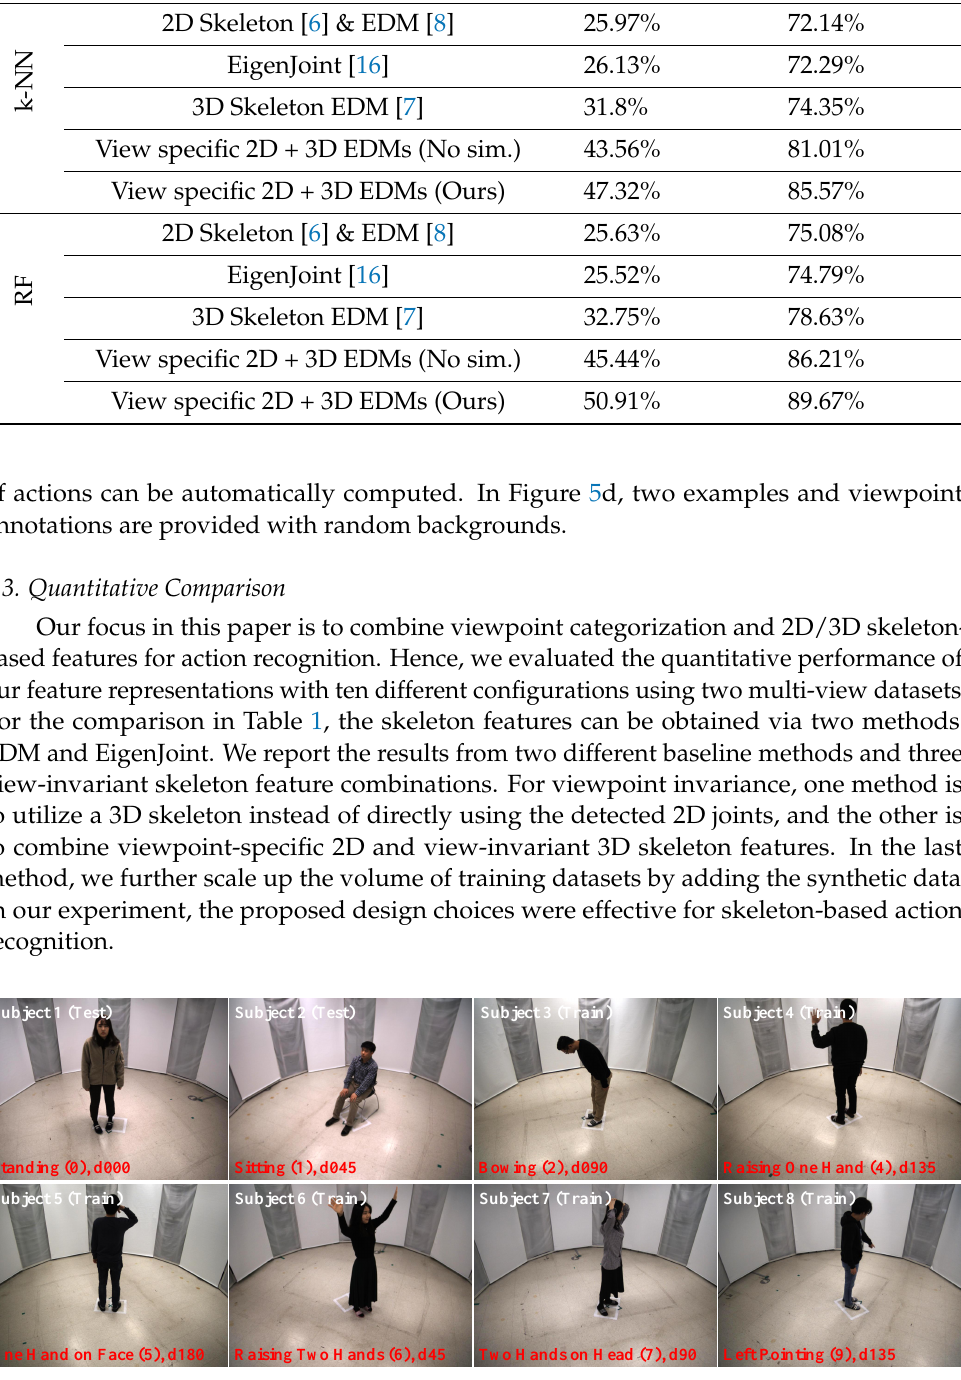
Figure 6. Data collection. Ten action categories from eight viewpoints were defined in the